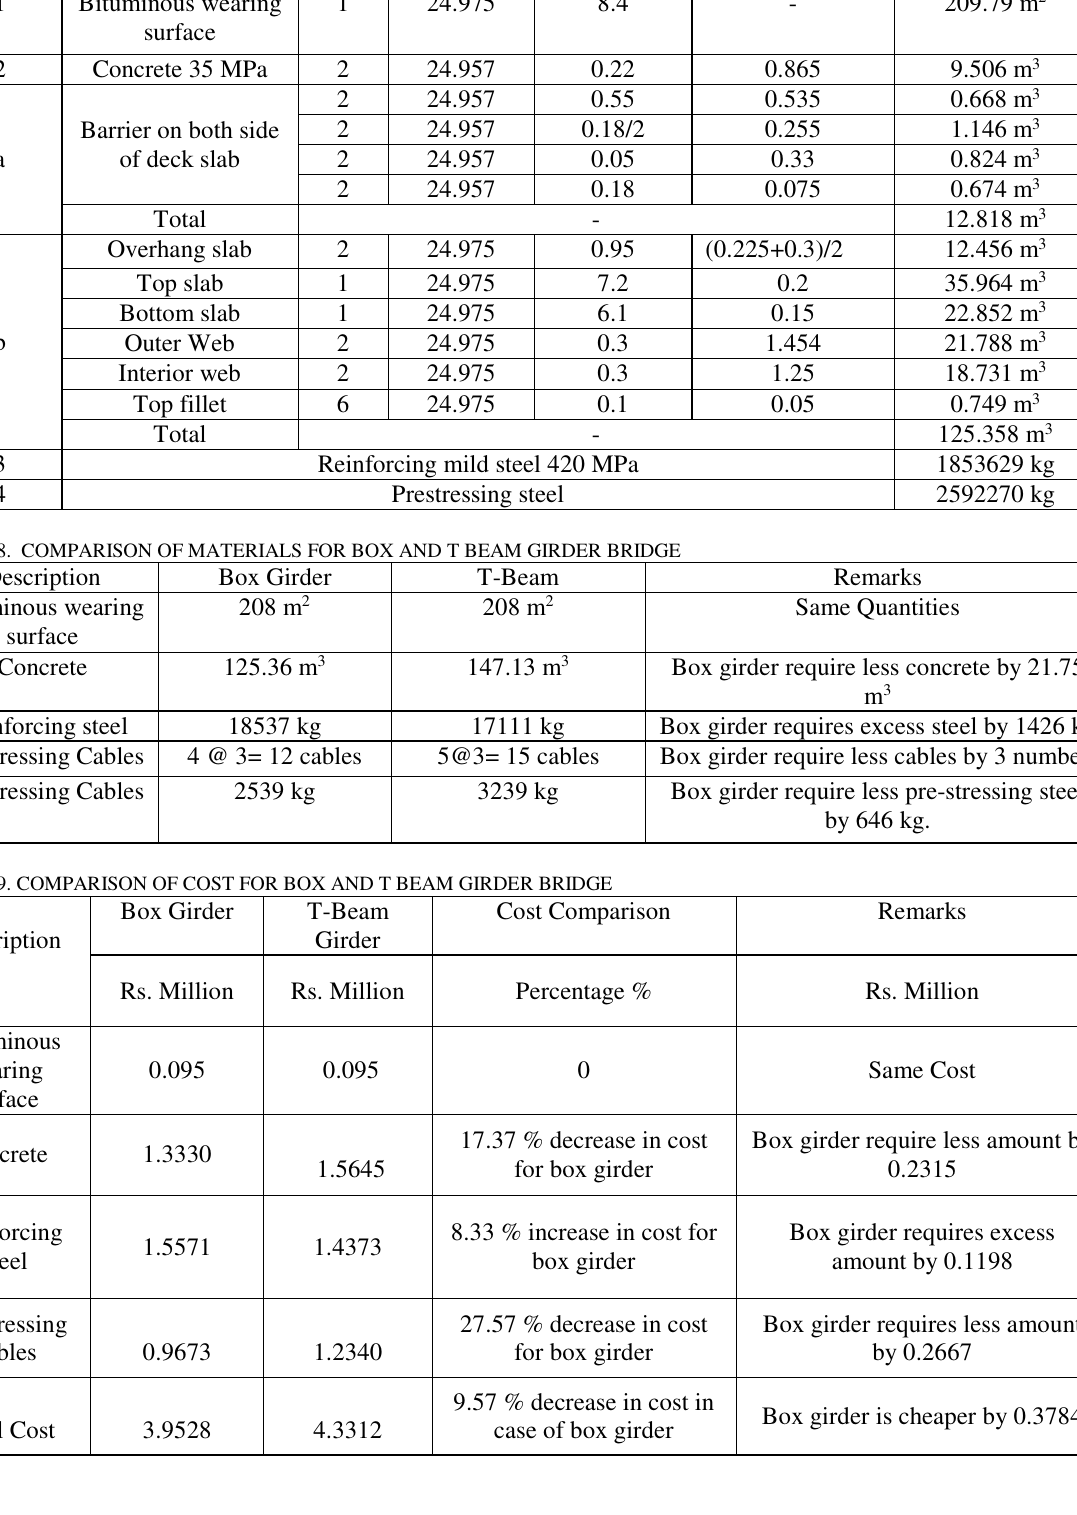
TABLE 6. BILL OF QUANTITIES FOR BOX GIRDER BRIDGE Sr. No.